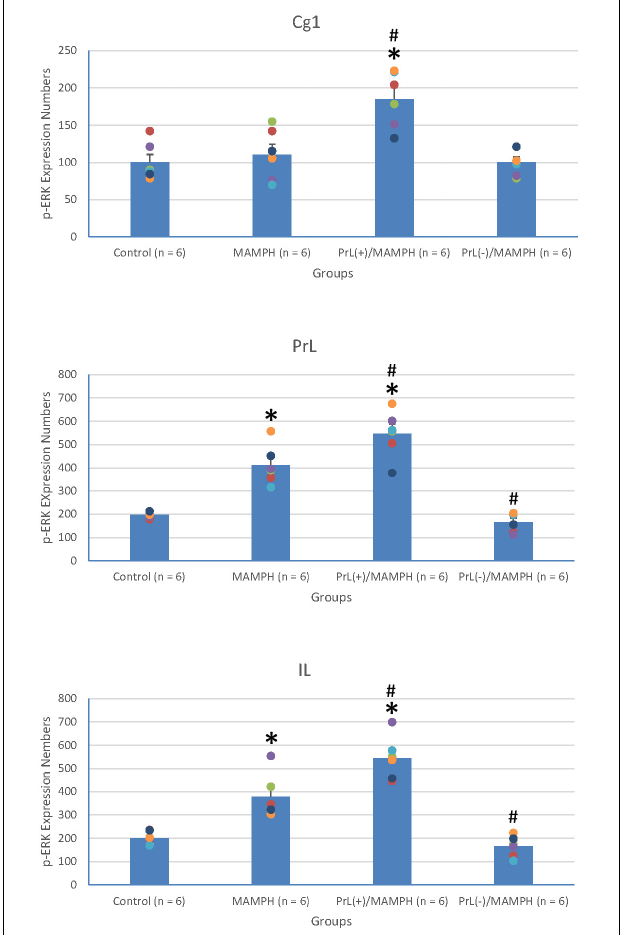
FIGURE 11 | MAMPH administrations were tested to label p-ERK expression in the Cg1, PrL, and IL of the mPFC for the control ( n = 6), MAMPH ( n = 6), PrL(+)/MAMPH ( n = 6), and PrL(–)/MAMPH groups ( n = 6) by injecting NMDA or saline into the PrL. PrL(+): Injection of a low concentration of NMDA to excite the PrL neurons; PrL(–): Injection of a high concentration of NMDA to destroy the PrL neurons. Differences in p-ERK expression levels in the Cg1, PrL, and IL among all groups were analyzed by one-way ANOVA, followed by Tukey’s post hoc test if a significant difference was appeared among groups. ∗ p < 0.05 indicates significant differences compared to the Control group; # p < 0.05 indicates significant differences compared to the MAMPH